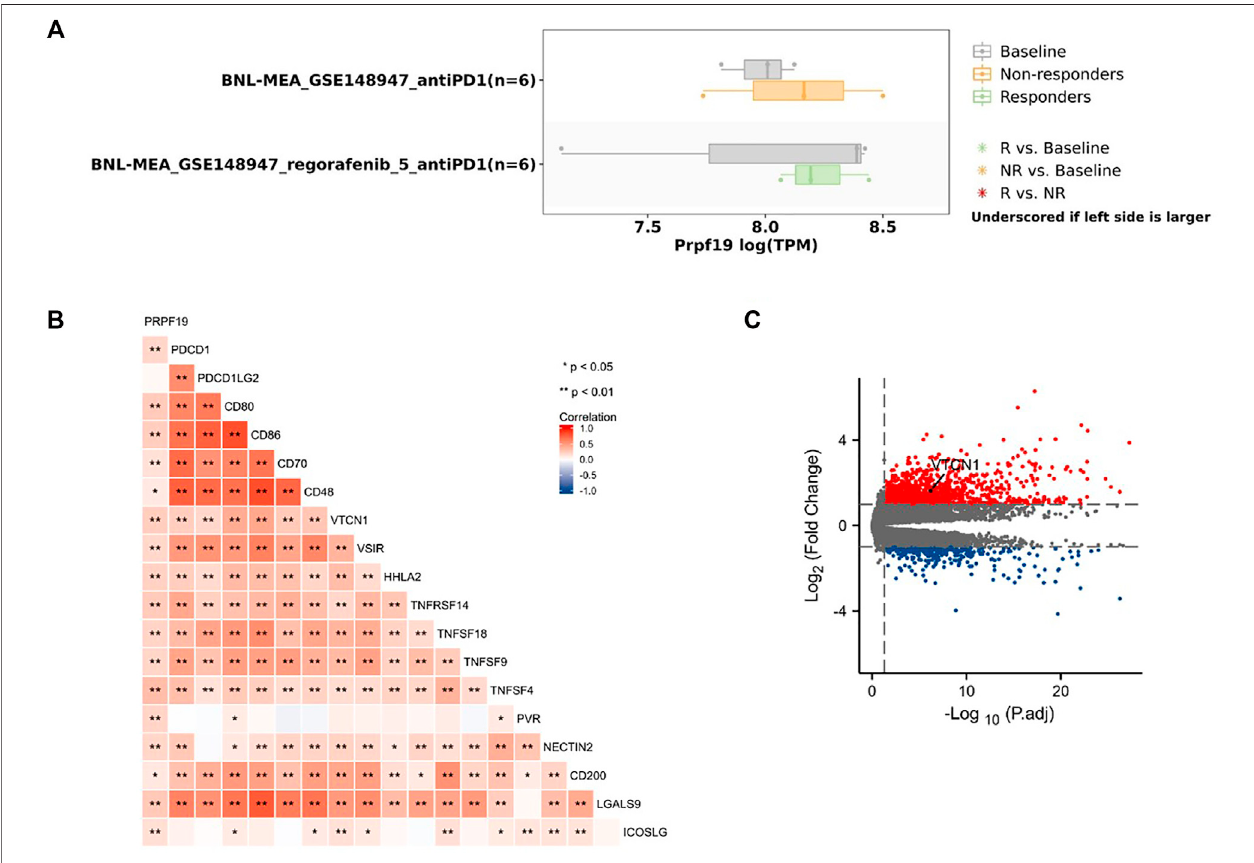
FIGURE 5 | PRPF19 might has a signi fi cant effect on the ef fi cacy of LIHC immunotherapy. (A) The same trend of PRPF19 expression pattern was seen with poor ICB responsive cell lines base on syngeneic mouse model (TISMO). (B) Heat map of the correlation between PRPF19 expression and immune checkpoint genes. (C) Volcanoplotshowingthesigni fi cantlyimmunosuppressivegene,VTCN1,inpatientswithhighPRPF19expressioncomparedwithpatientswithlowPRPF19expression.